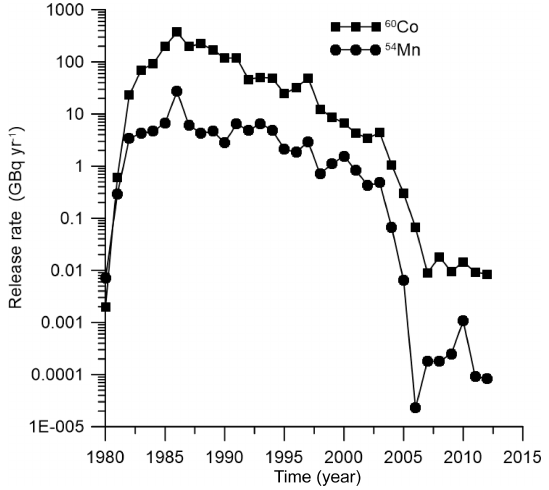
Figure 7. Release rates of 60 Co and 54 Mn according to measure- ments (Forsmark,